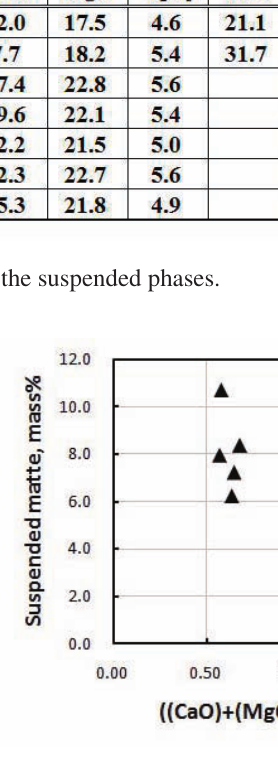
Figure 8. Total amount of suspended matte within slag as a function of (CaO C MgO) = SiO 2 of slag in Table